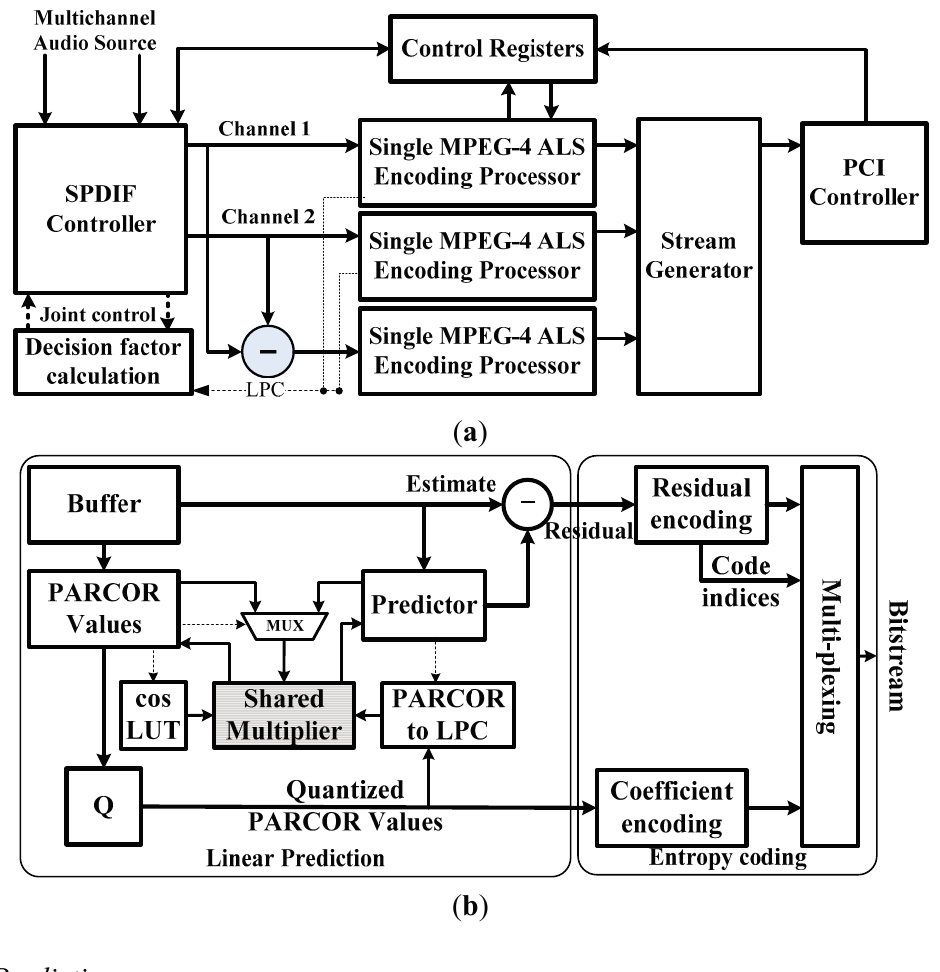
Figure 5. Block diagram for MPEG-4 ALS encoder: ( a ) architecture of real-time multichannel MPEG-4 ALS hardware encoder and ( b ) single MPEG-4 ALS encoding